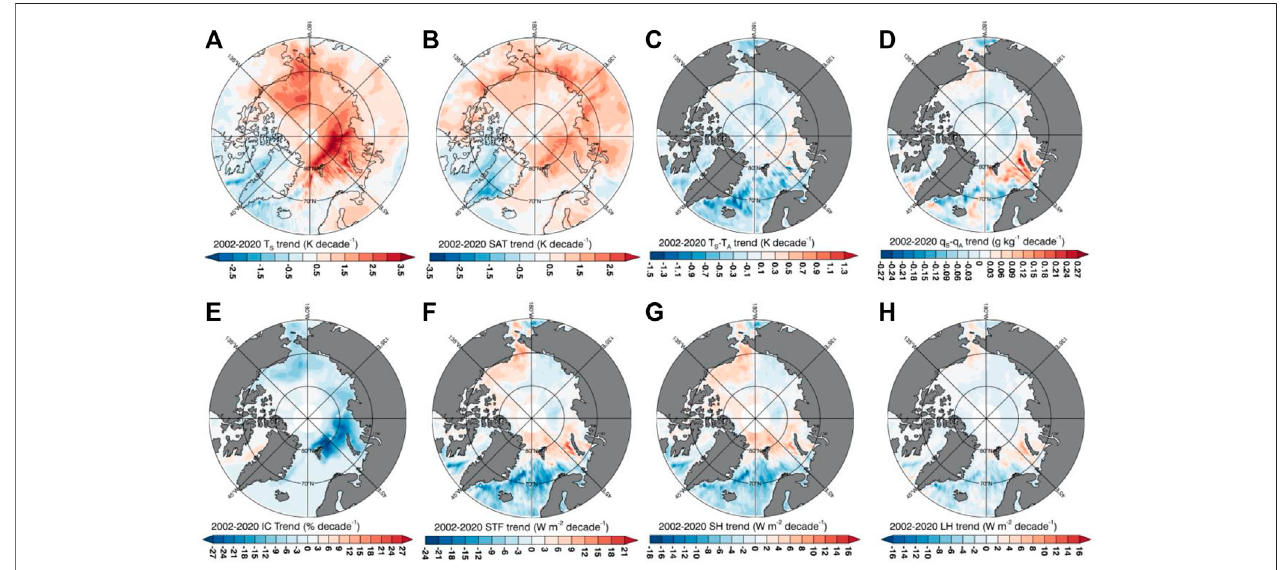
FIGURE 3 | Winter (ONDJ) decadal trends in (A) AIRS surface skin temperature, (B) AIRS surface air temperature, (C) AIRS T S − T A , (D) AIRS q S − q A , (E) observed I C , (F) AIRS-derived surface turbulent fl ux, (G) AIRS-derived SHF and (H) AIRS-derived LHF.